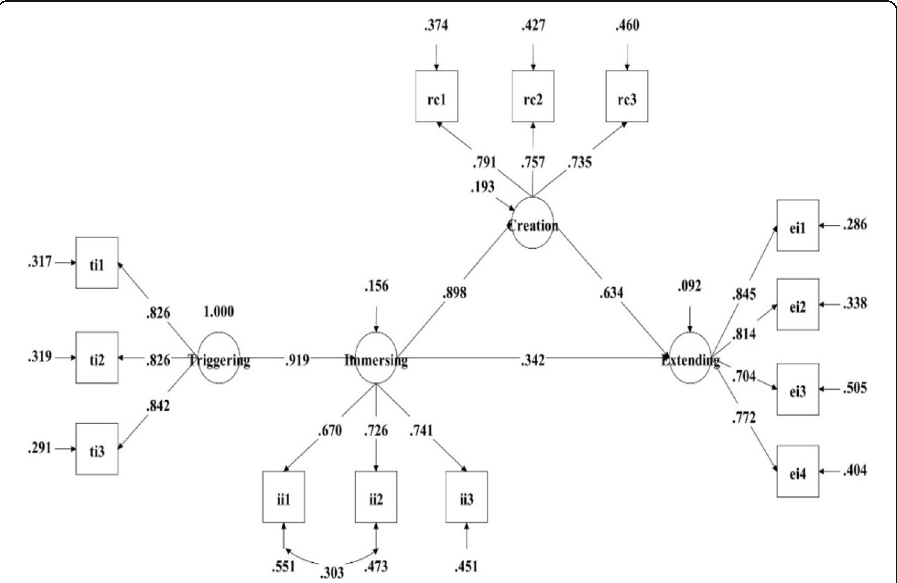
Fig. 2 Results of path coefficients. Note . Triggering = triggering interest; Immersing = immersing interest; Extending = extending interest; Creation = robotic